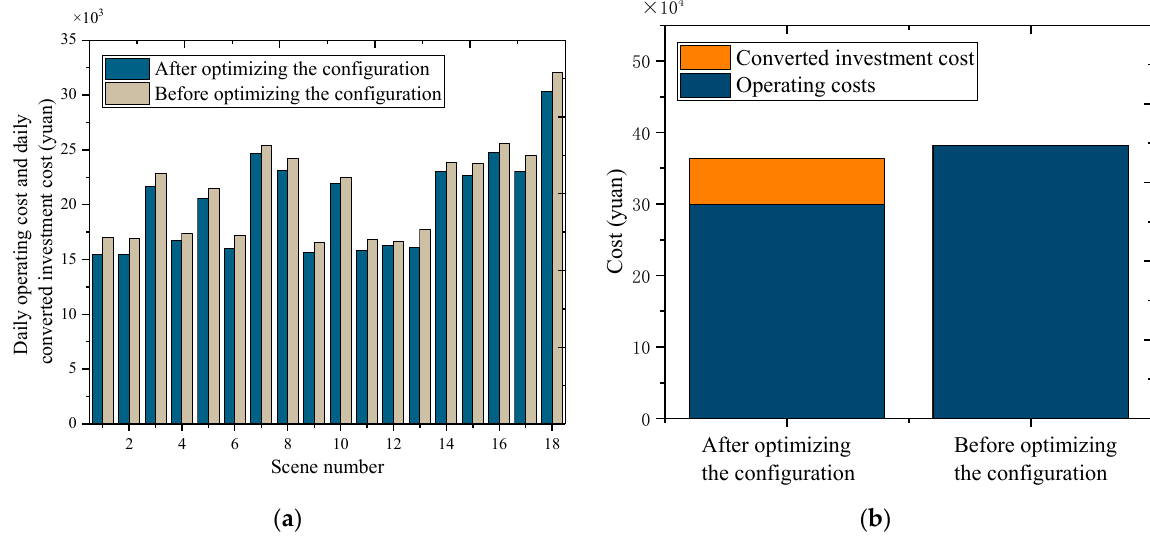
Figure 18. ( a ) System operating costs in each scenario; ( b ) total operating cost of the system in all